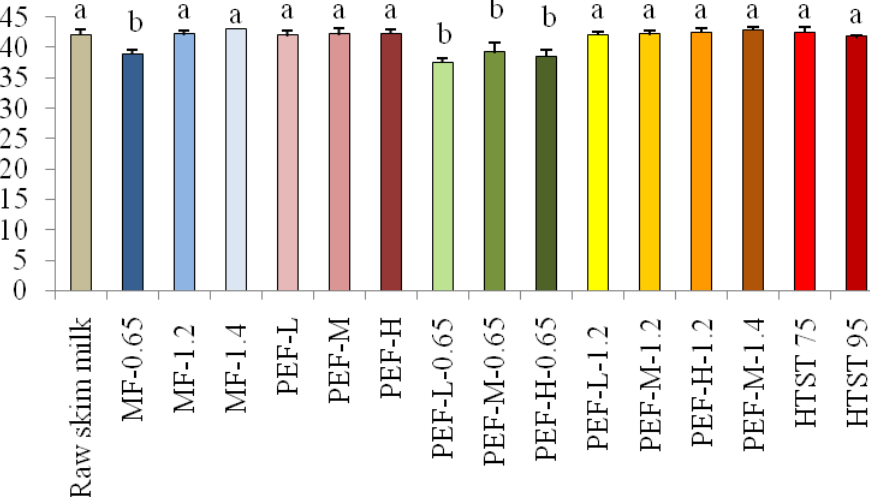
Figure 1. Whiteness obtained in untreated raw skim milk and by processing the latter with low-intensity (PEF-L), medium-intensity (PEF-M) and high-intensity (PEF-H) pulsed electric field, 0.65 (MF-0.65), 1.2 (MF-1.2), and 1.4 (MF-1.4) μm microfiltration, high-temperature short-time (HTST) pasteurization treatments and different pulsed electric field-based combinations with microfiltration treatments (after conversion from Hunter Lab color space data to CIE 1931 XYZ color space values). Different letters ( i.e. , a , b ) above bars indicate significant differences between treatment means ( p <